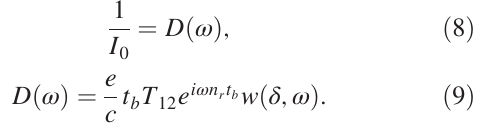
FIG. 14. Comparison of the I formulas and BMAD simulation for N p ¼ 2 . Parameters: ct